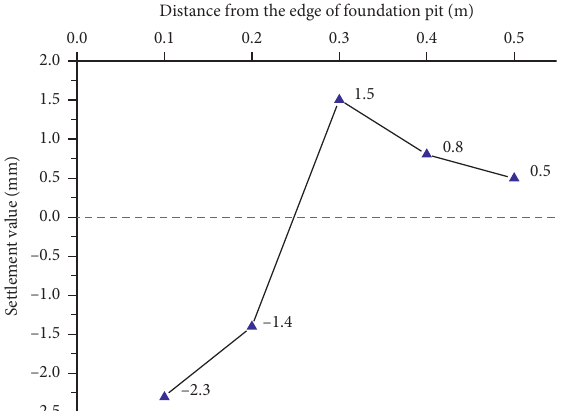
Figure 31: Surrounding ground settlement value when the foundation pit is excavated to the bottom.